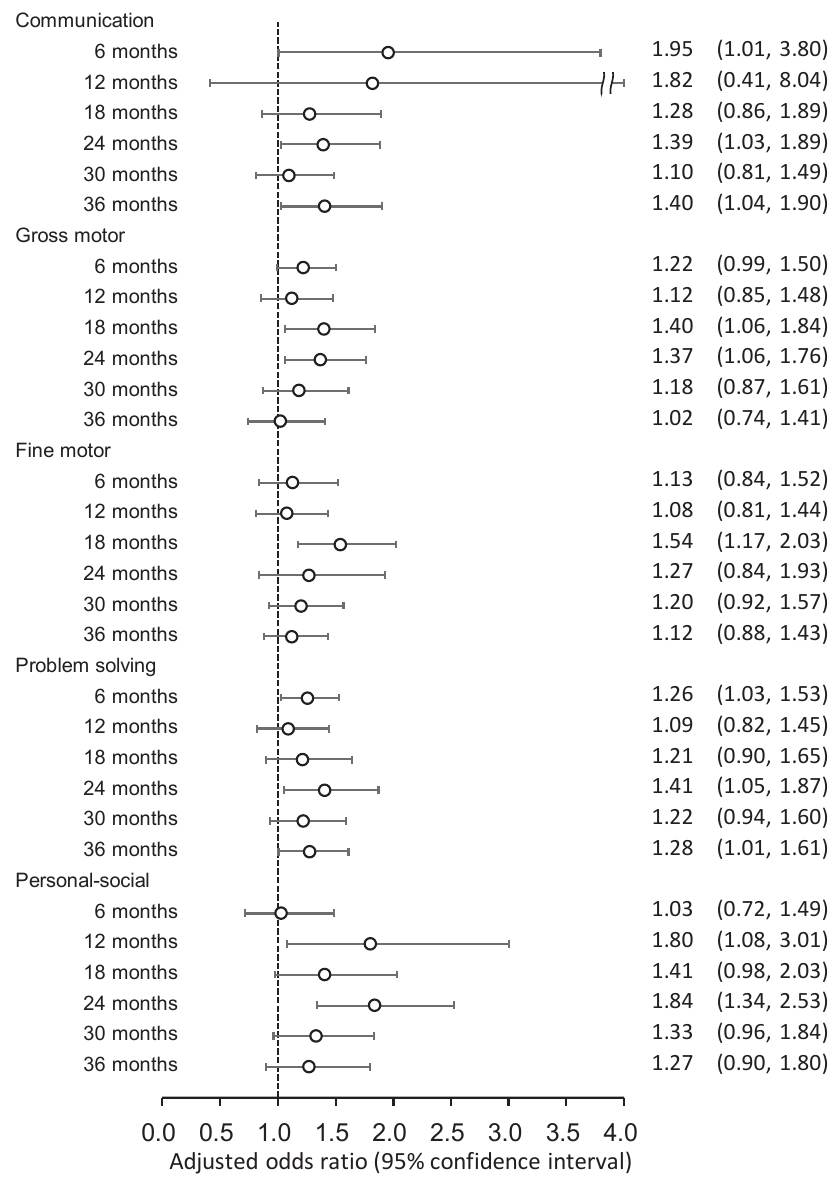
Fig. 2 Association of epidural analgesia during labor with neurodevelopmental delay among children Adjusted odds ratios (95% con fi dence intervals) for neurodevelopmental delay in each domain of the J-ASQ-3 among children born to mothers who received epidural analgesia during labor are shown from age 6 to 36 months. Adjusted for maternal age at delivery, parity, delivery mode, duration of labor, comorbidity (diabetes and hypertension), body mass